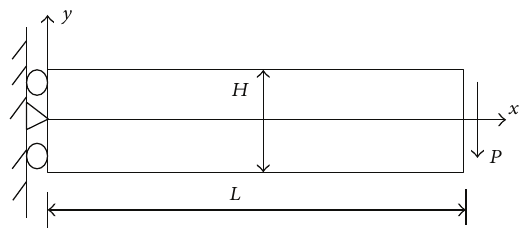
Figure 2: Cantilever